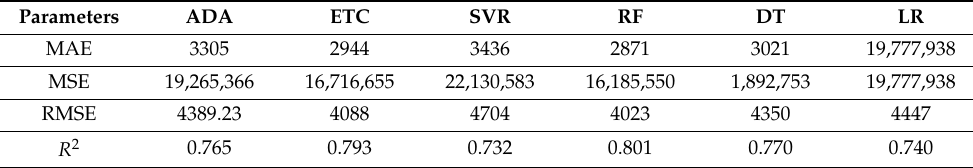
Table 10. Performance of machine learning models for water consumption prediction.